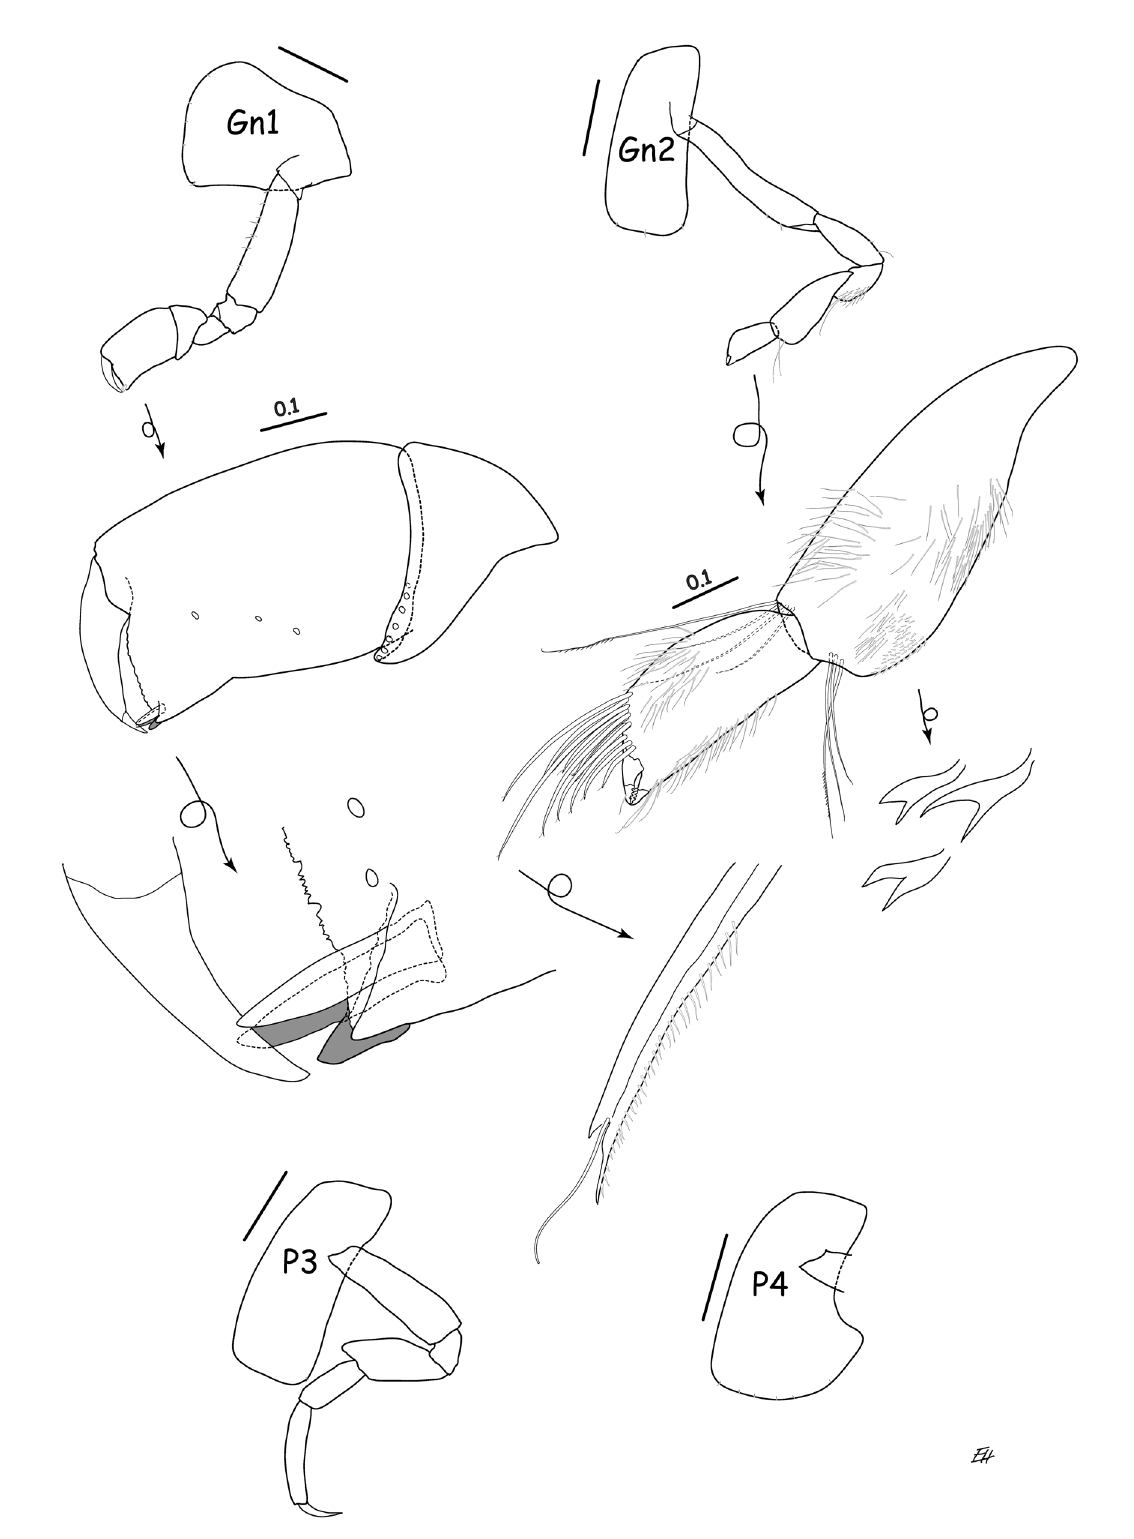
Fig. 34. Abyssorchomene shannonae sp. nov., allotype, ♂, 7 mm (ZMH K-61210). Setae omitted on Gn1 detail and P3. Scale bars = 0.5 mm unless indicated